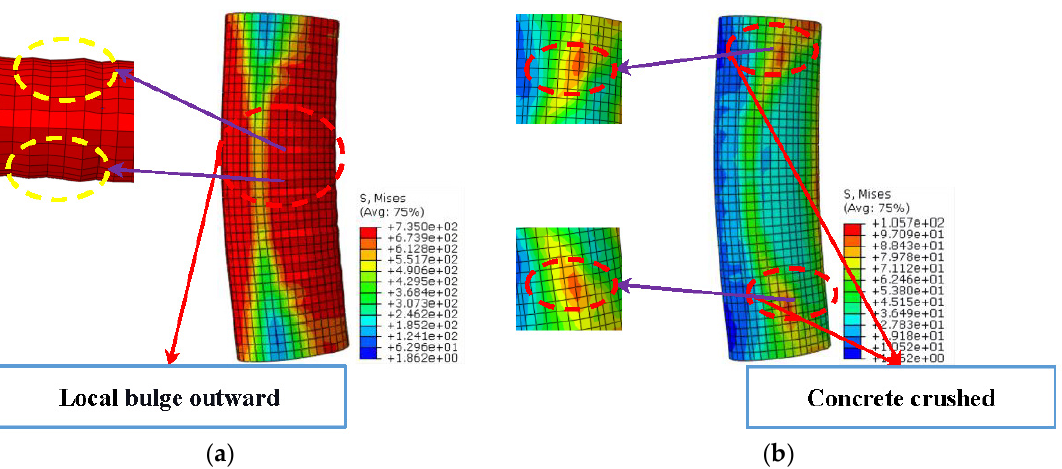
Figure 21. The final failure mode of typical specimen HUCFEST-18: ( a ) steel tubes; ( b ) concrete.